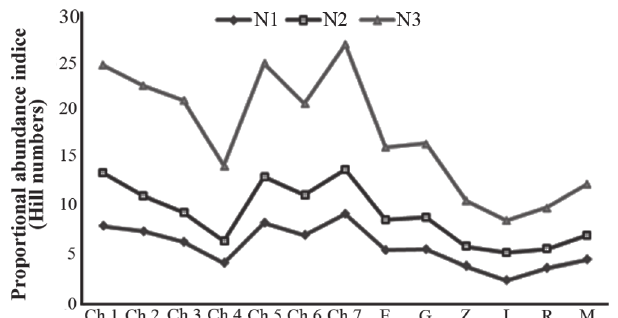
Fig. 5. Index of proportional abundance (series of Hill’s number) for the habitats that conform the Chacmochuch lagoon System, indicating the number of species of fish with average abundance (N1), number of very abundant species (N2) and the number of rare species (N3).